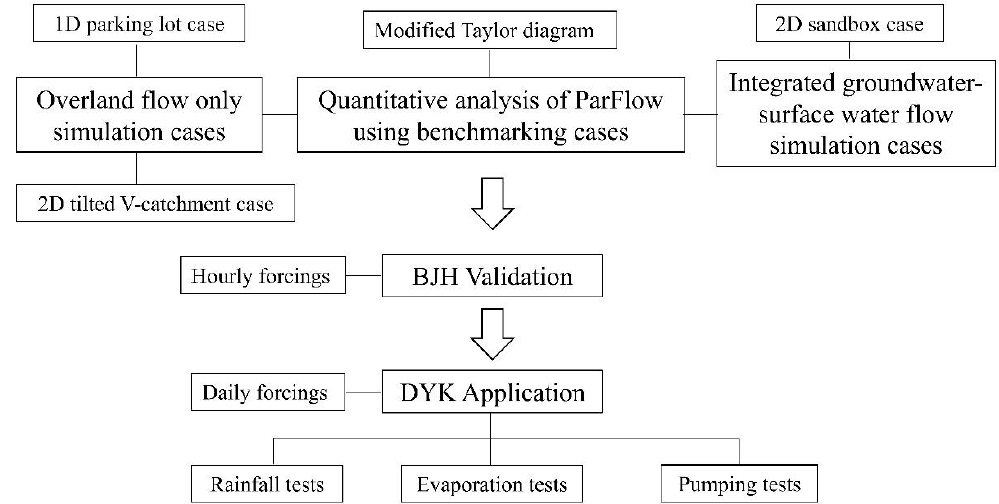
Figure 2. Flow chart: from benchmarking cases to the Heihe River Basin case studies.